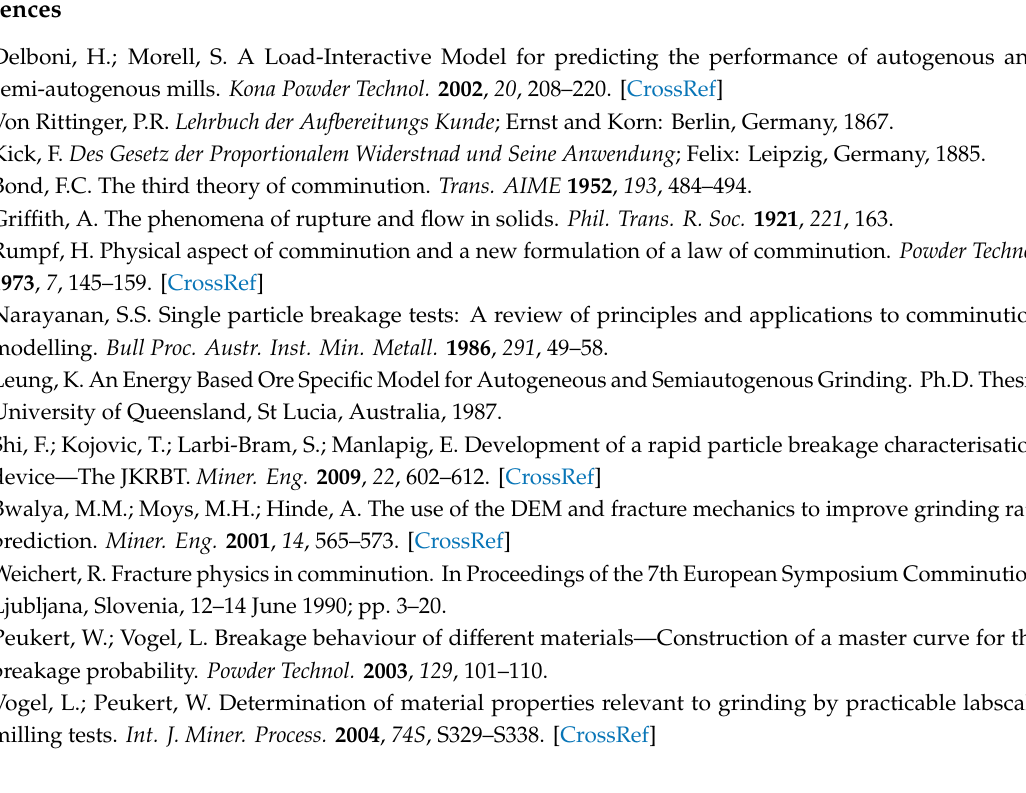
Figure A2. Algorithm that applies drop weight test and DEM simulation data to calculate milling rate.